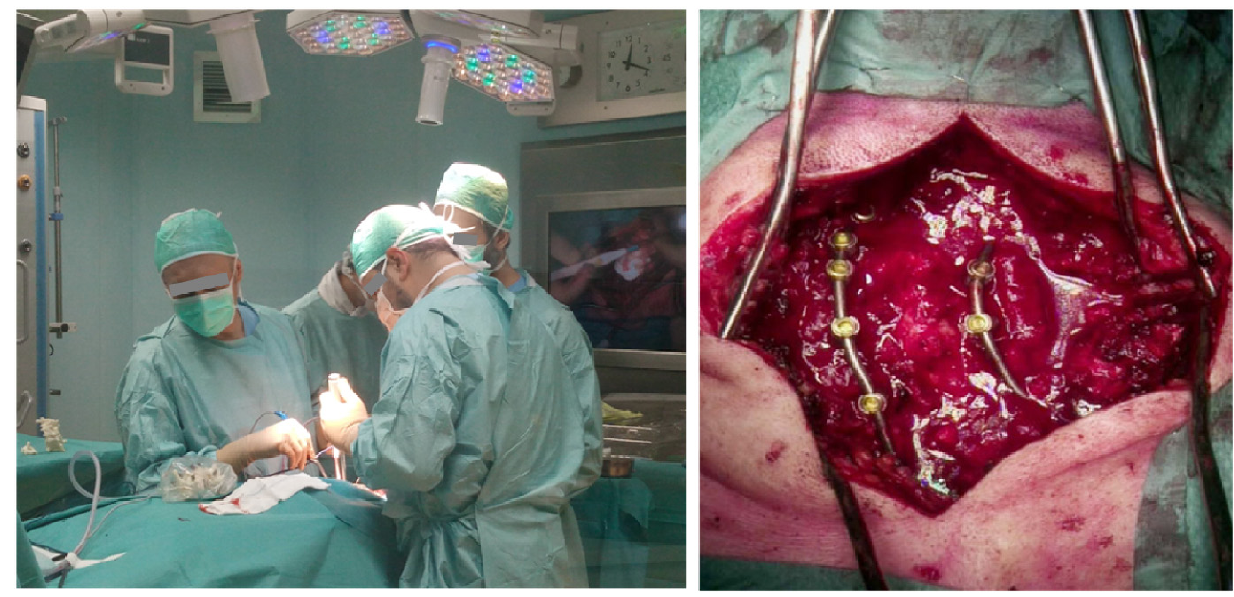
Figure 6. Surgical scenario showing the PLA-3DP well-visible to the surgeon, thus offering a valuable intra-operative support ( left ); fixation screws and rods after final positioning before final suturing ( right ).